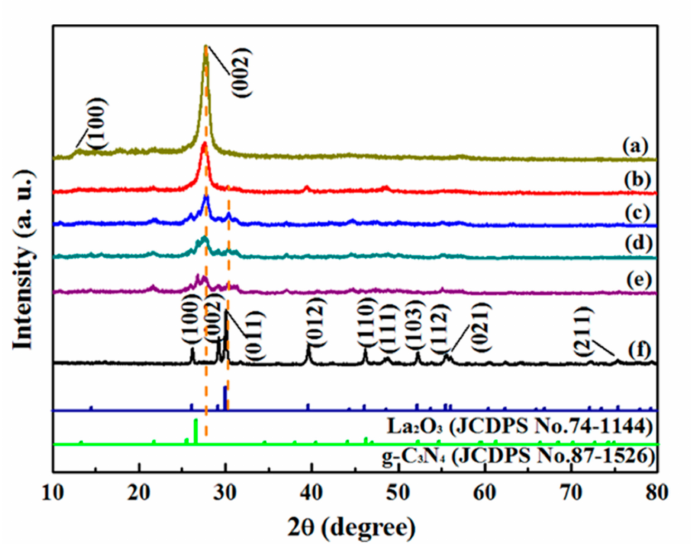
Figure 1. XRD patterns of CN (a), 5LaO/CN (b), 10LaO/CN (c), 15LaO/CN (d), 20LaO/CN (e), LaO (f) samples and standard card.